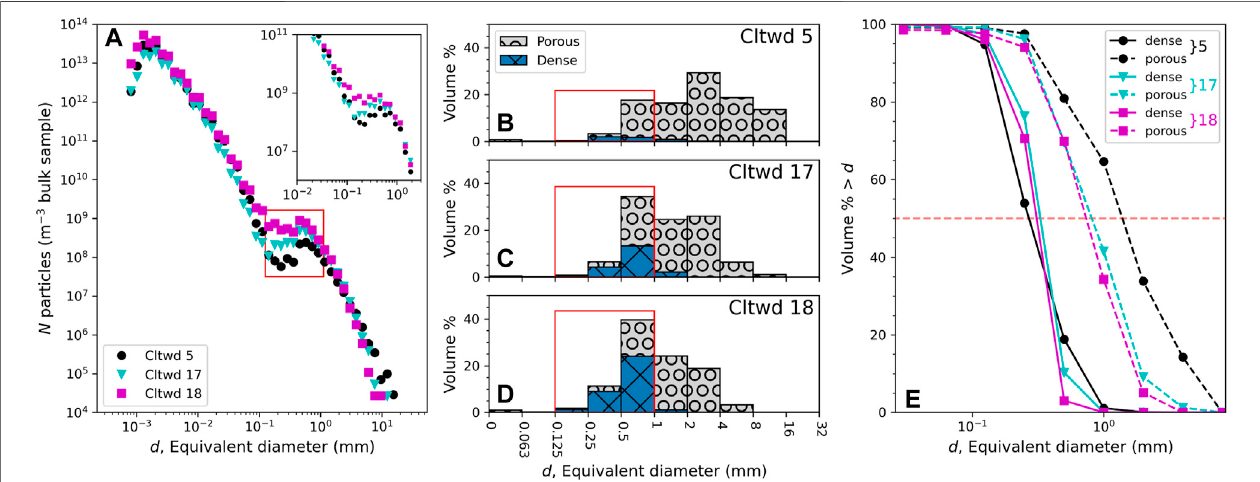
FIGURE 13 | (A) Number density, N , vs equivalent diameter, d , for the end of lower Cleetwood at locations Cltwd 5, 17, and 18, which are all located on the main dispersal axis at 46 km, 56 km, and 66 km from the proposed vent location, respectively. Note the sudden increase in number density of particle for ~0.1 mm < d < ~1 mm (red rectangle). Inset shows N vs d using laser diffraction data only and further illustrate that this increase is not an artifact of merging datasets (see also Figure 3B ). (B-D) Volume percent of porous and dense material vs d for locations Cltwd 5, 17, and 18, respectively. Note the increase of the proportion of dense particles in sizerange 0.125 – 1 mm with increasing distancefrom the vent (red rectangles). (E) Cumulative volumedistribution for porous (dashed lines) and dense (solid lines)materialatCltwd5,17,and18.Mediangrain-sizesareattheintersectionsofthesedistributionswithavolumepercentof50%(i.e.,horizontalreddashedline).Note the slight increase in the median diameter of dense particles from Cltwd 5 to Cltwd 17 and 18, which we attribute to particle rafting, whereas the median diameter of the porous particles logically decreases with increasing distance from the vent.